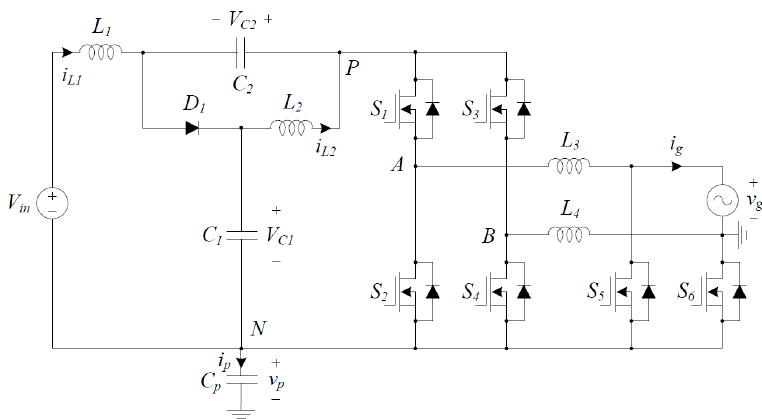
Figure 2. Circuit diagram of the proposed inverter.